Question: What style of plot is this figure drawn as?
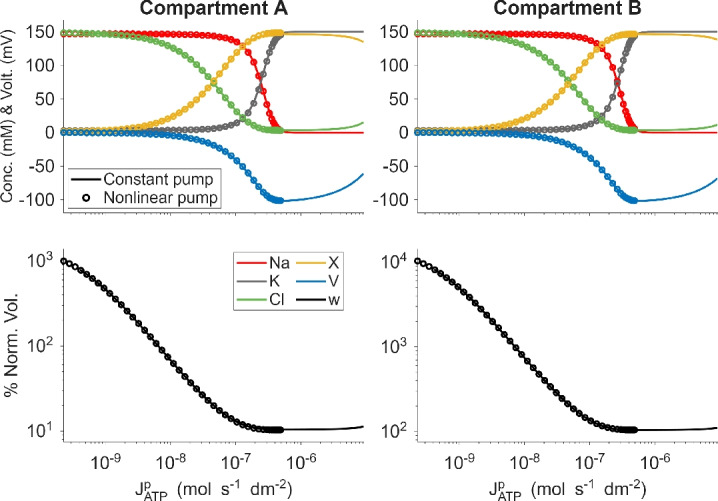
Answer: line